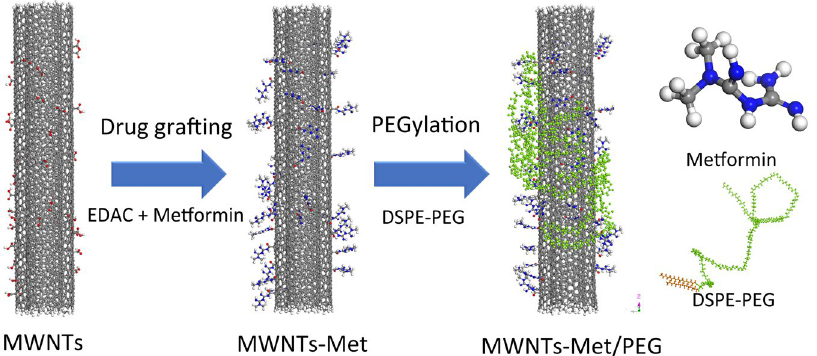
Figure 1. Illustration diagram of MWNTs-Met/PEG